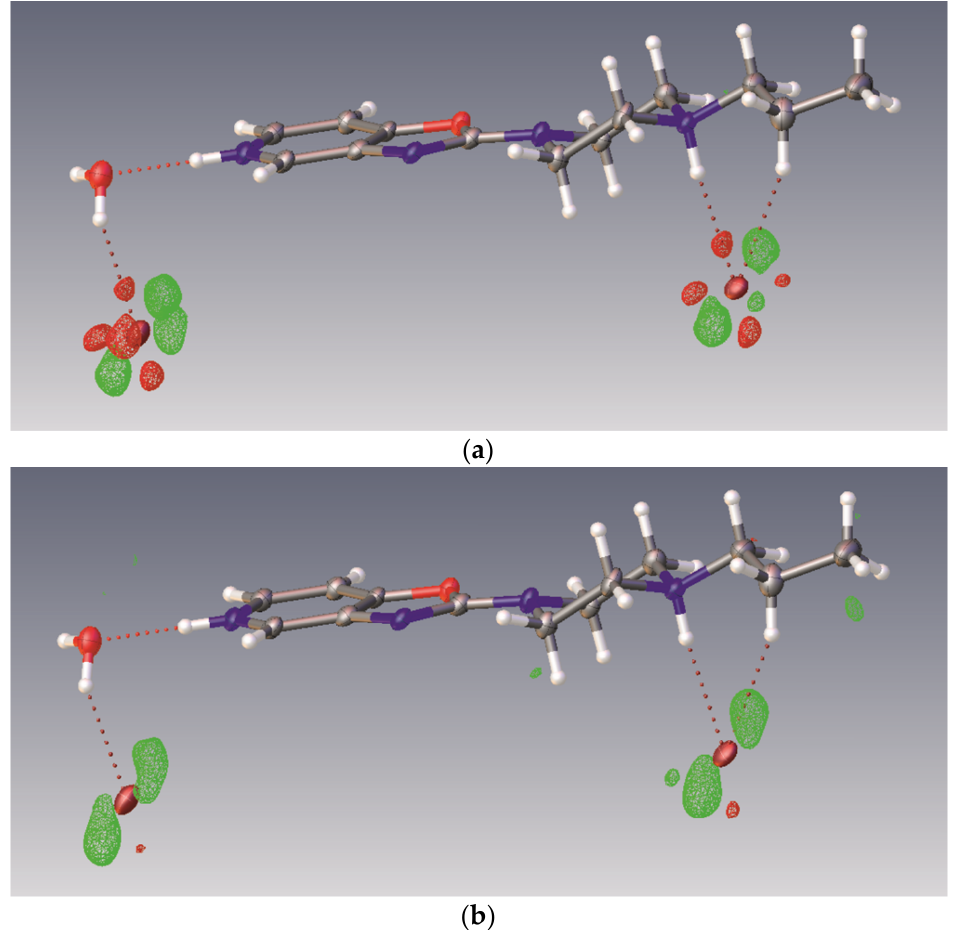
Figure 2. Difference Fourier electron density maps for 1. ( a ) Harmonic approximation to displacement factors for non-hydrogen atoms resulting in Δρ max = 1.6 and Δρ min = 1.0 (eÅ − 3 ). ( b ) Anharmonic approximation to the Br ion displacements taking into account 10 components of C ijk and 15 components of D ijkl symmetric tensors resulting in Δρ max = 1.1 and Δρ min = 0.4 (eÅ − 3 ). Drawing prepared with Olex2 v.1.3.0 [29].